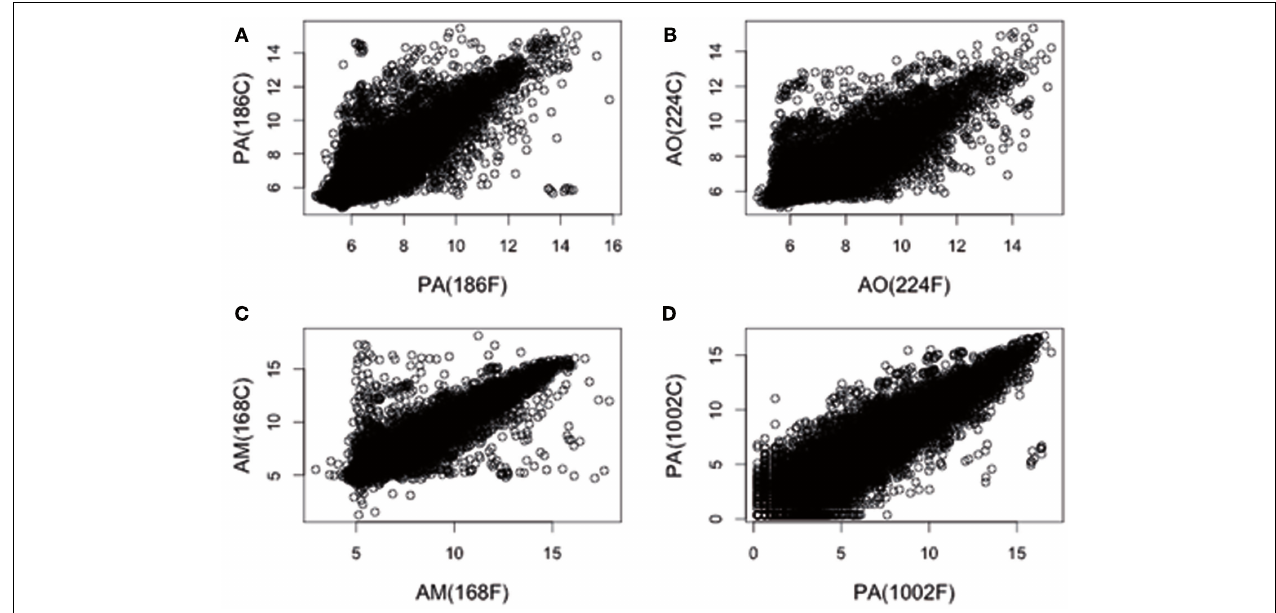
(sample 1002) samples, respectively.The degree of similarity of each sample respect to its primary culture has been quantitatively explored by calculating the associated correlation coefficients. Average Pearson’s correlation coefficients were: (A) , 0.88; (B) , 0.86; (C) , 0.94, and (D) ,